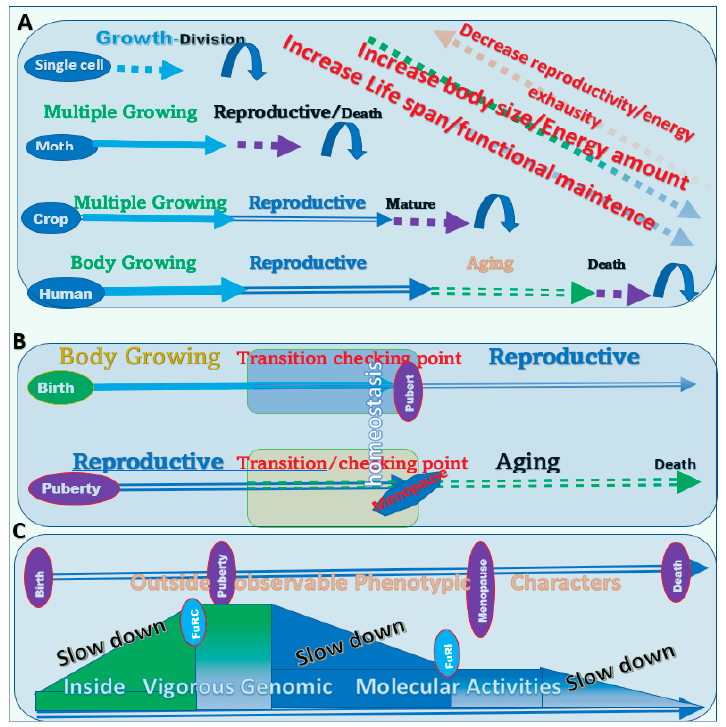
Figure 5. Rules of longevity and essential checkpoints for a long lifespan. ( A ) In the kingdoms of life on earth, lifespan is highly positively associated with body size and negatively associated with productivity. ( B ) The unrecognized transition period between key life stages. There should be tran- sition periods between body growth and body maturity/reproductivity and between reproductivity and post-productivity or the aging stage. ( C ) The changes in life stages are the result of accumulative genomic activities that are not observable by the human